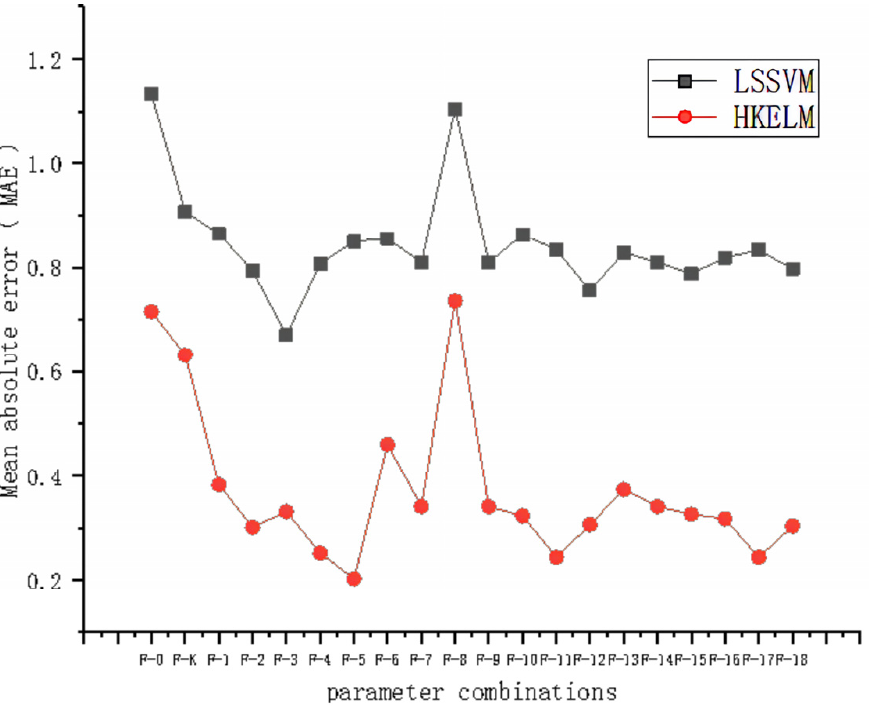
Figure 5. Comparison of the optimization results of different parameter sets under different algo- rithms.